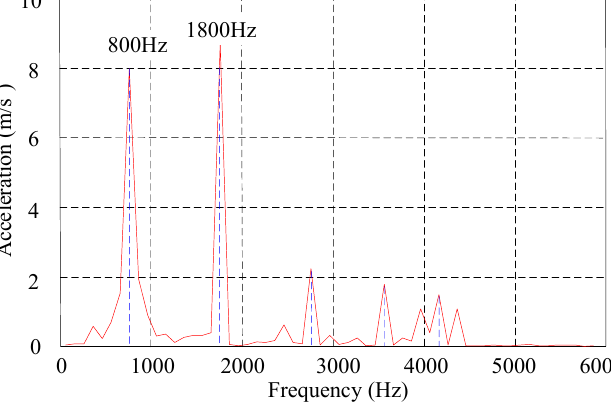
Figure 7. Acceleration spectrum of outer stator surface.